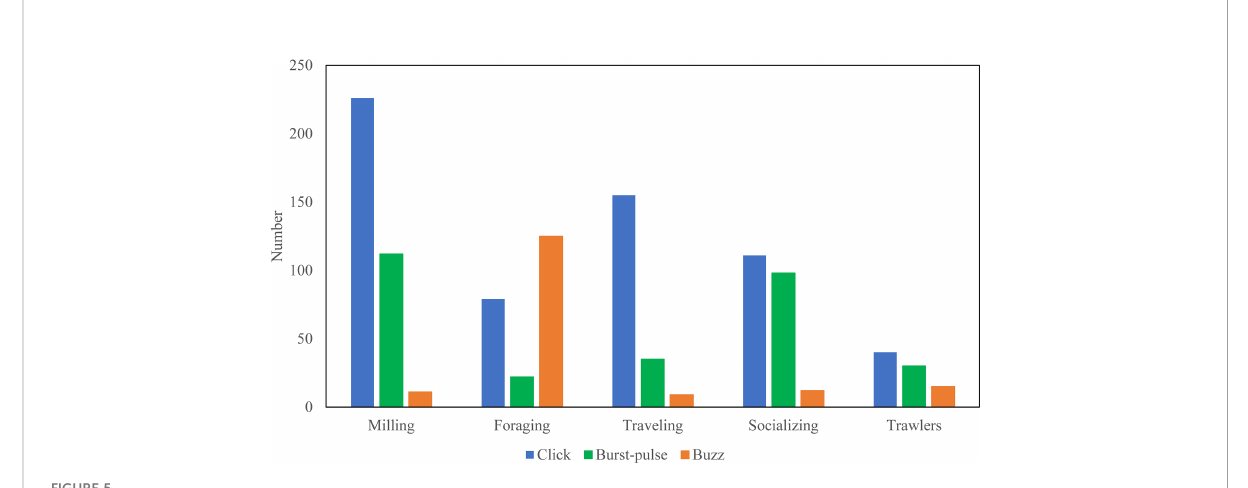
FIGURE 5 The total call number of different types by behavioral